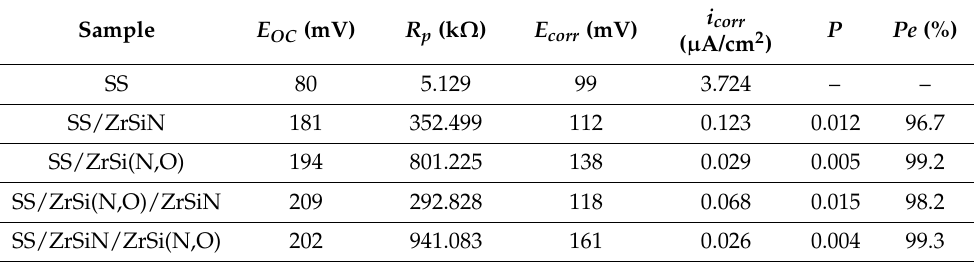
Figure 5. Open circuit potential evolution in time ( a ) and Tafel plots of the investigated specimens ( b ). Table 2. Corrosion parameters of the coatings: open circuit potential ( E OC ), polarization resistance ( R p ), corrosion potential ( E corr ), corrosion current density ( i corr ), porosity ( P ), and protective efficiency ( P e ).